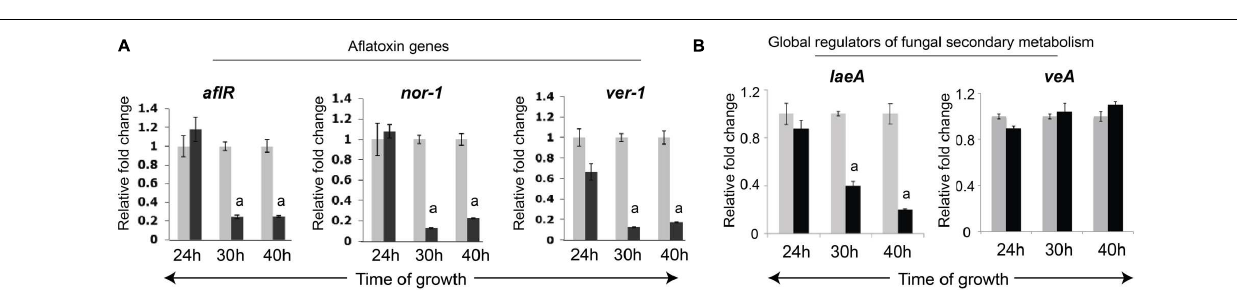
FIGURE 6 | Effects of ARMs on Aspergillus parasiticus gene expression. (A) Comparison of transcript accumulation of aflatoxin-synthesis regulatory genes in A. parasiticus . mRNA levels for each gene were observed at 24 h (aflatoxin synthesis start point), 30 and 40 h time points (aflatoxin synthesis is activated and reaches peak levels by 40 h). Black bars, cells grown in presence of ARMs (2 µ g/mL), Gray Bars, DMSO (vehicle) control. (B) Comparison of transcript accumulation of two global regulators of secondary metabolism, veA and laeA at the same time-points. Statistical significance of difference in transcript accumulation between control and ARMs-treated cells were determined using an unpaired t -test with sample size of 3 and two tailed p < 0.05 set as level of significance. a, p <